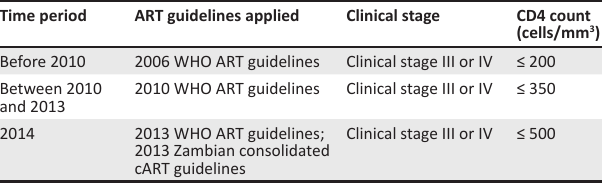
TABLE 1: Eligibility criteria for initiation on combination antiretroviral therapy across different time periods. Time